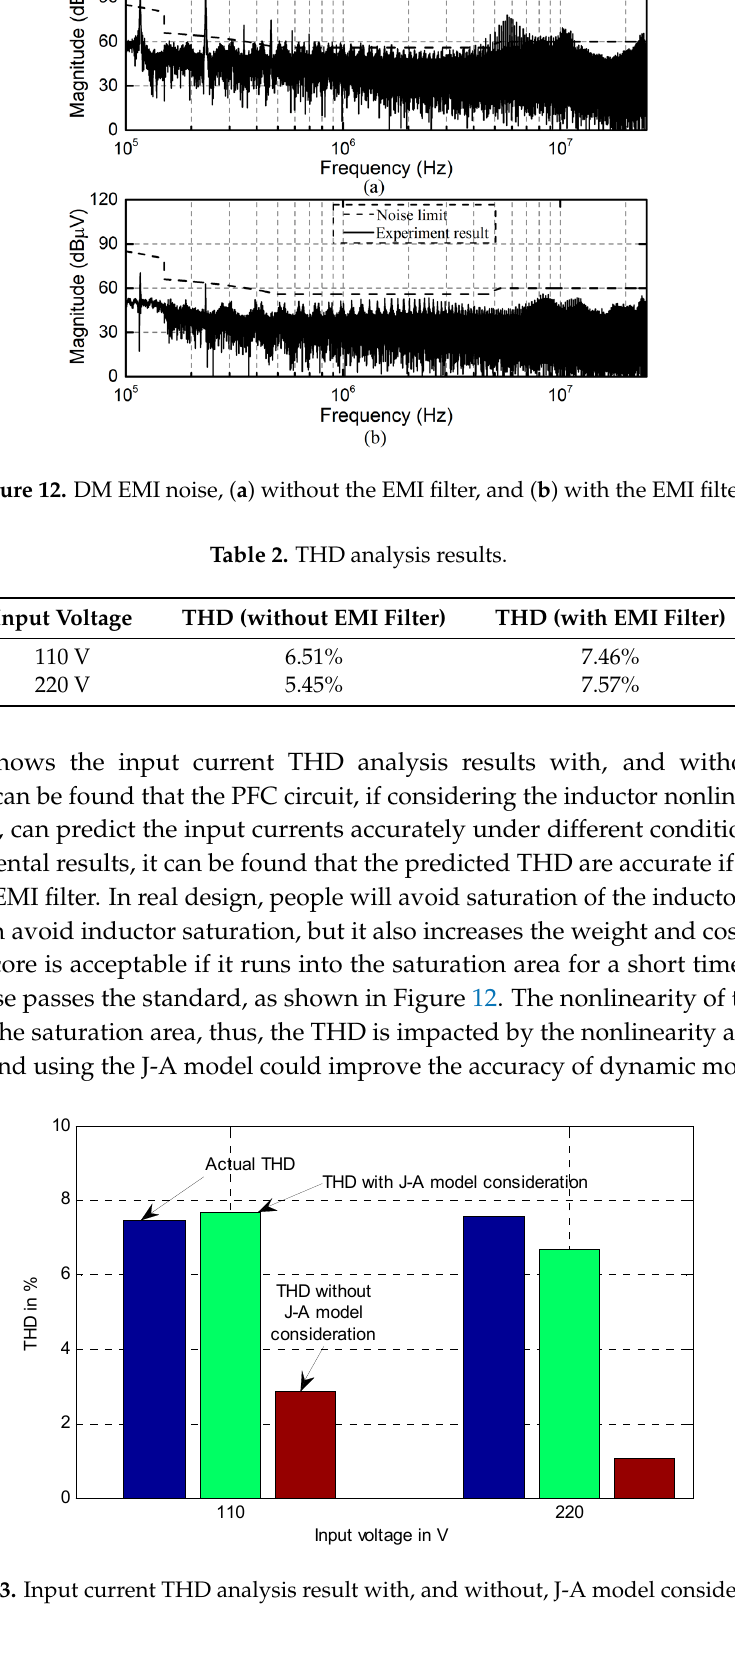
Figure 12. DM EMI noise, ( a ) without the EMI filter, and ( b ) with the EMI filter.